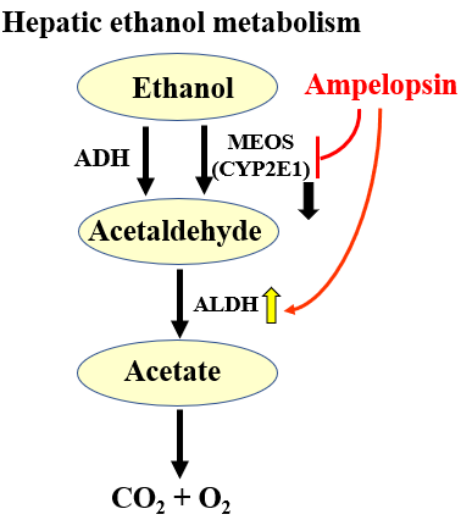
Figure 10. Potential underlying pathway by which AG extract and ampelopsin contribute to ethanol metabolism in the liver.